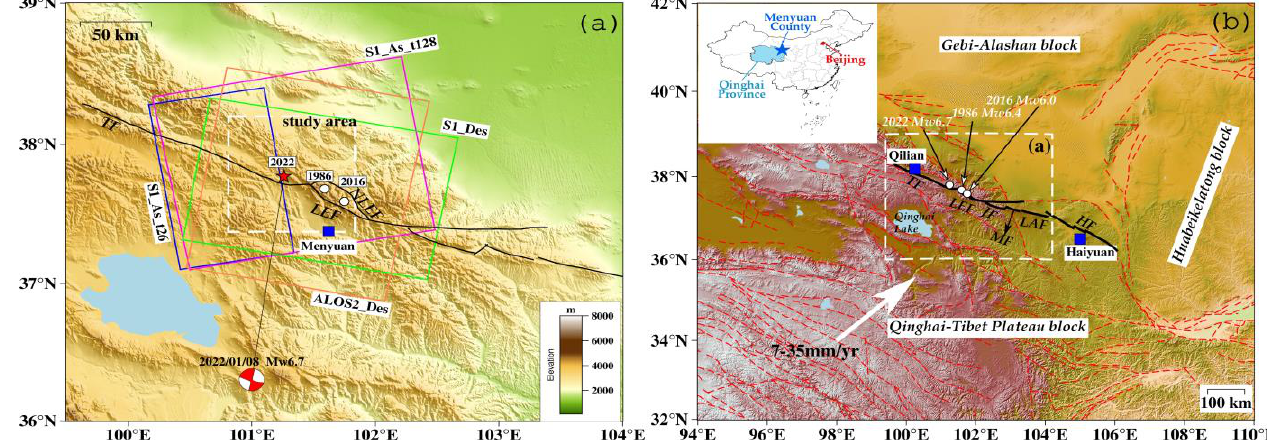
Figure 1. ( a ) Color-shaded relief map. The solid rectangles represent the footprint of the used SAR data. The white dashed rectangle outlines the study area (i.e., the range of Figures 2–5). The black lines are the location of mapped faults. The red beach ball and the red star are the focal mechanism and the epicenter of the 2022 Menyuan earthquake, respectively. White circles are two historic Mw > 6.0 earthquakes near the Lenglongling Fault (LEF) and the northern LEF (NLEF) that occurred in 1986 and 2016. The blue square is Menyuan county. ( b ) The tectonic setting around the study area. The red dashed lines are the mapped faults. The bold black lines are the QHFS with the Tuolaishan fault (TF), LEF, Jinqianghe fault (JF), Maomaoshan fault (MF), Laohushan fault (LAF), and Hauyuan fault (HF). The white dashed rectangle indicates the range of ( a ). The insert map shows the location of Menyuan county (the blue star) in China. The white arrow denotes the northeastward movement (about 7 – 35 mm/year) of the Qinghai – Tibet Plateau block [6,7] . Blue squares are Qilian county and Haiyuan county.